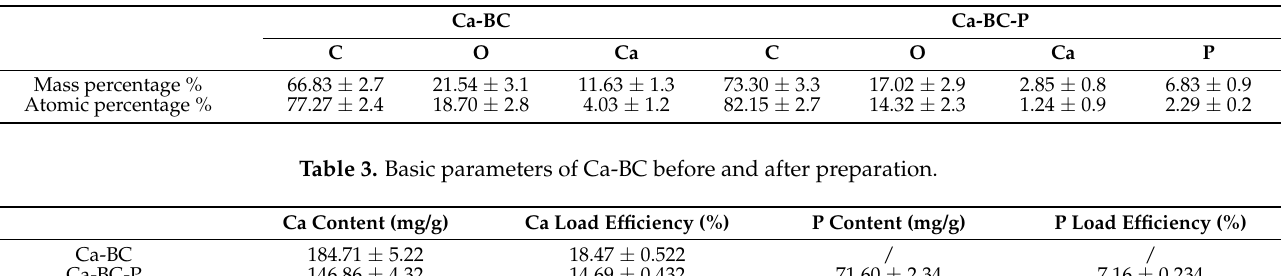
Table 2. EDS spectrum analysis results of Ca-BC and Ca-BC-P.